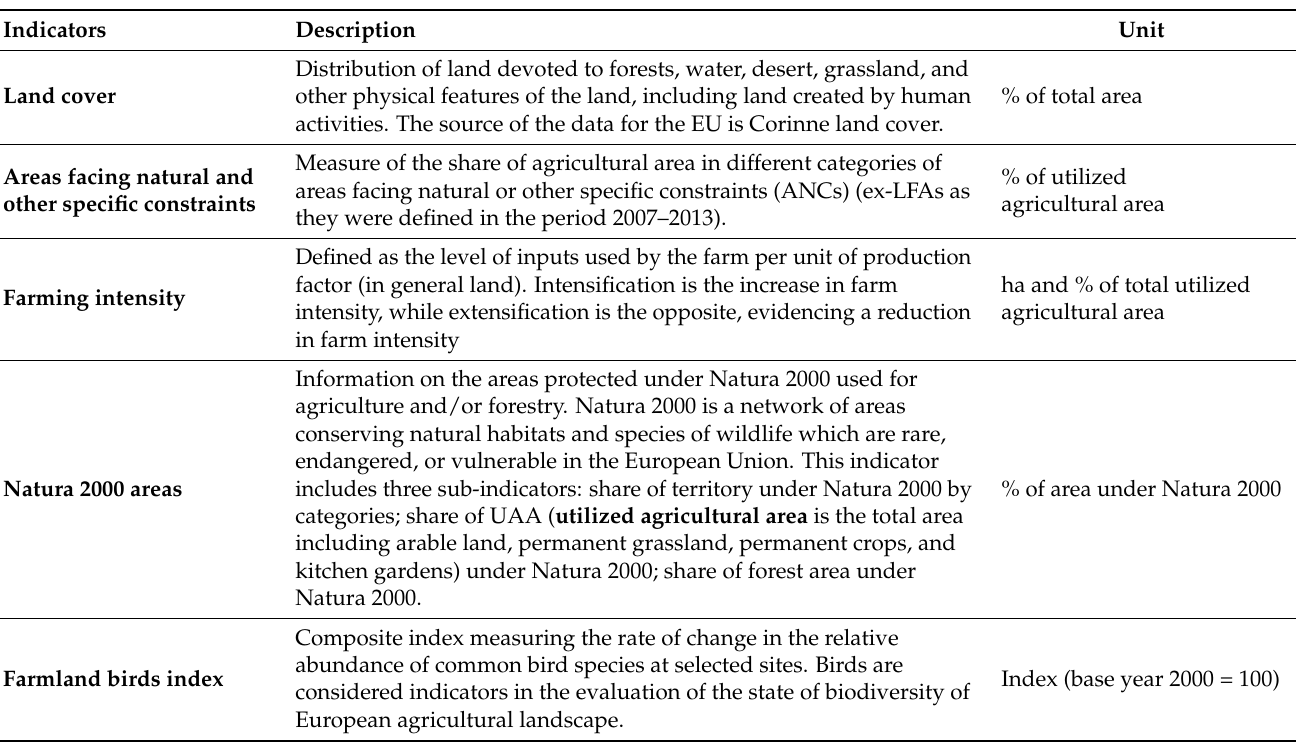
Table 3. Environmental performance indicators of European Union Common Agricultural Policy (CAP). Source of the data: EU CAP indicators database